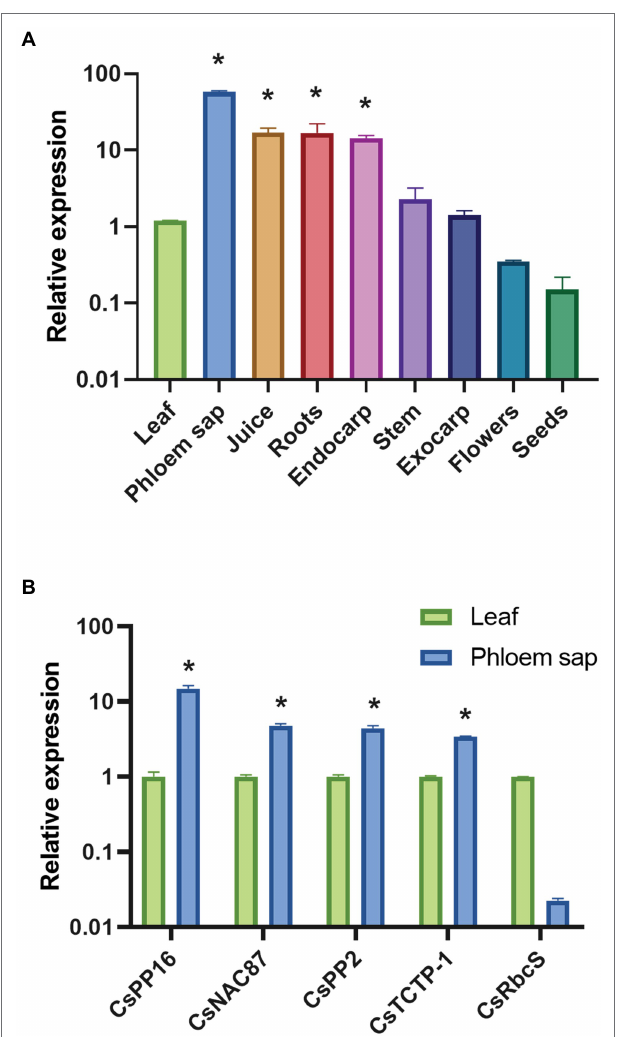
FIGURE 2 | CsPP16 potentially interacts with phloem proteins as determined by molecular docking. Docking protein–protein graphs showing the interaction of CsPP16 (blue) with CsRBP50 ( A , green), CsHCS70 ( B , red), and CseIF5A ( C , orange), Citrus sinensis orthologous of Cucurbita maxima proteins known to interact with CmPP16. Root Mean Square Deviation values are indicated next to each molecular docking that CsPP16 interacts with CsRBP50 ( Figure 2A ), CsHSC70 ( Figure 2B ), and CseIF5A ( Figure 2C ). The molecular docking